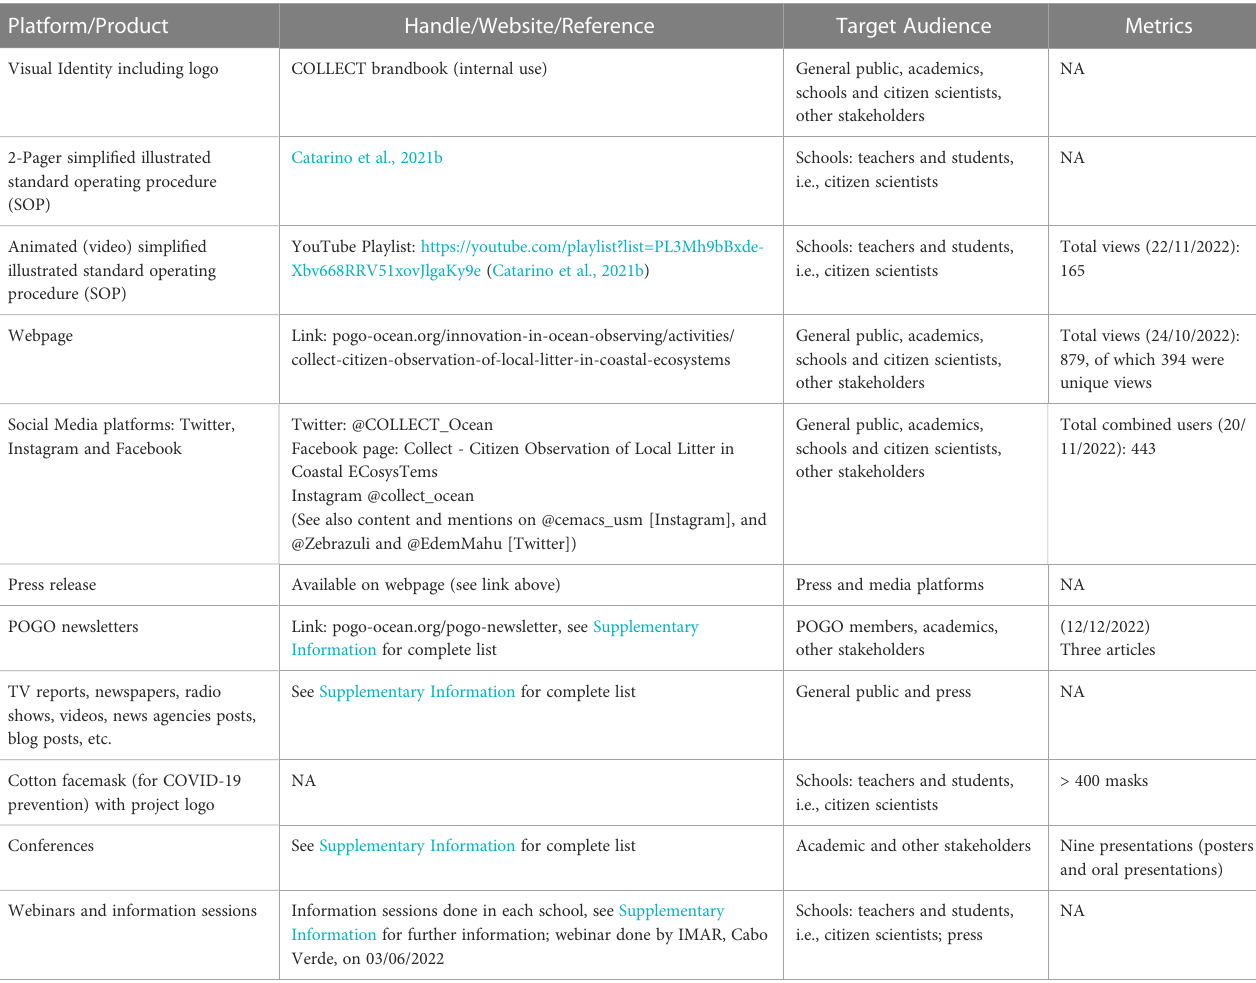
TABLE 1 Communication activities related to the project COLLECT, with information on platforms and products created during the project, target audiences and metrics (when